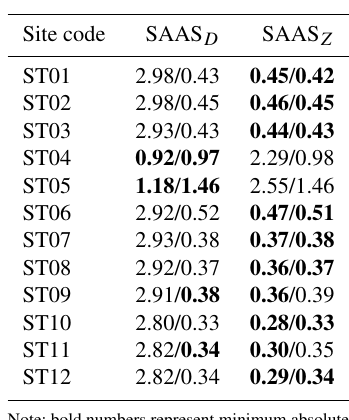
Table 2. Mean absolute bias (MAB)/standard deviation (SD) of SAAS D and SAAS Z biases (unit: mm).